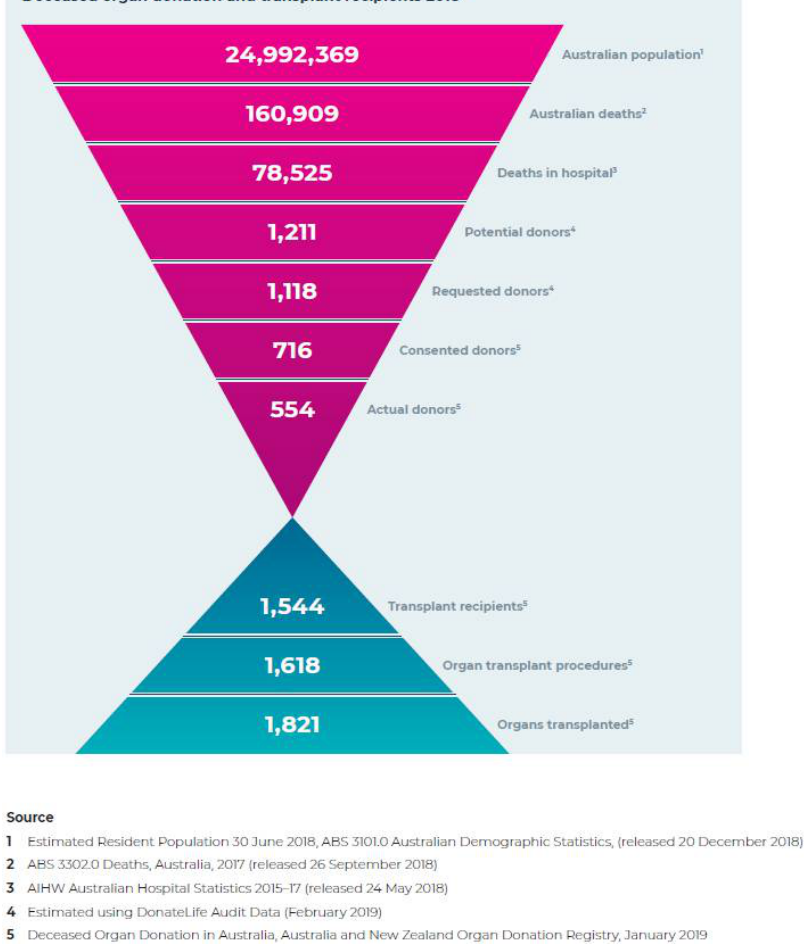
Figure 1. Funnel diagram obtained from Donatelife, NSW website www.donatelife.gov.au (accessed